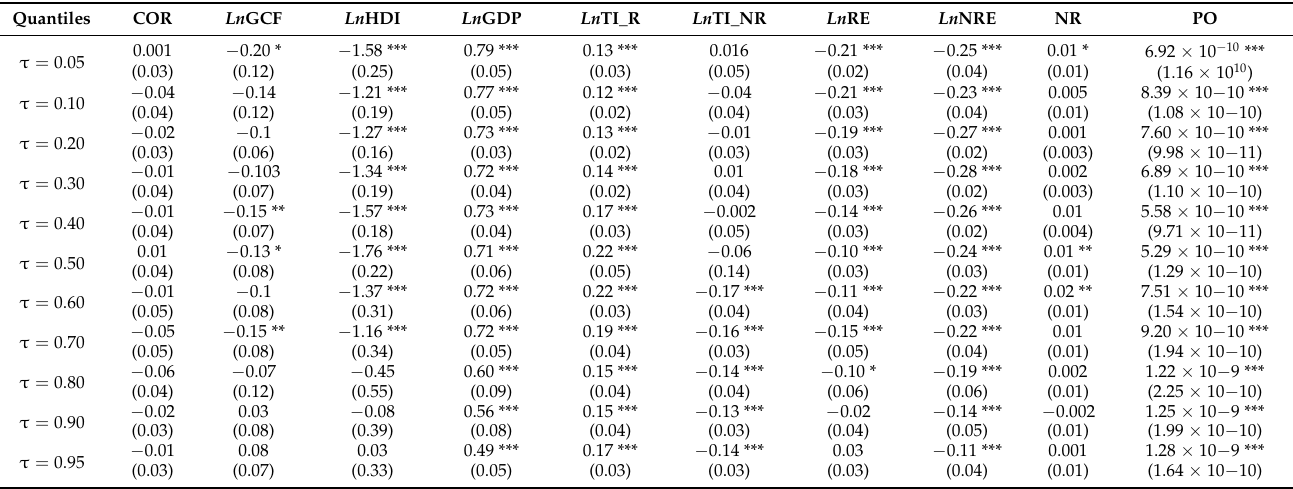
Table 7. Panel quantile regression